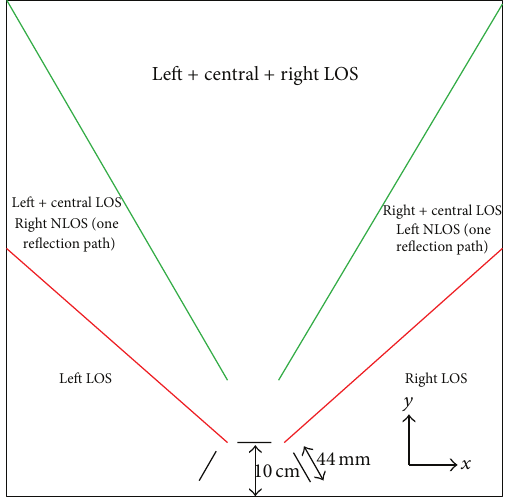
Figure 7: Coverage areas for our